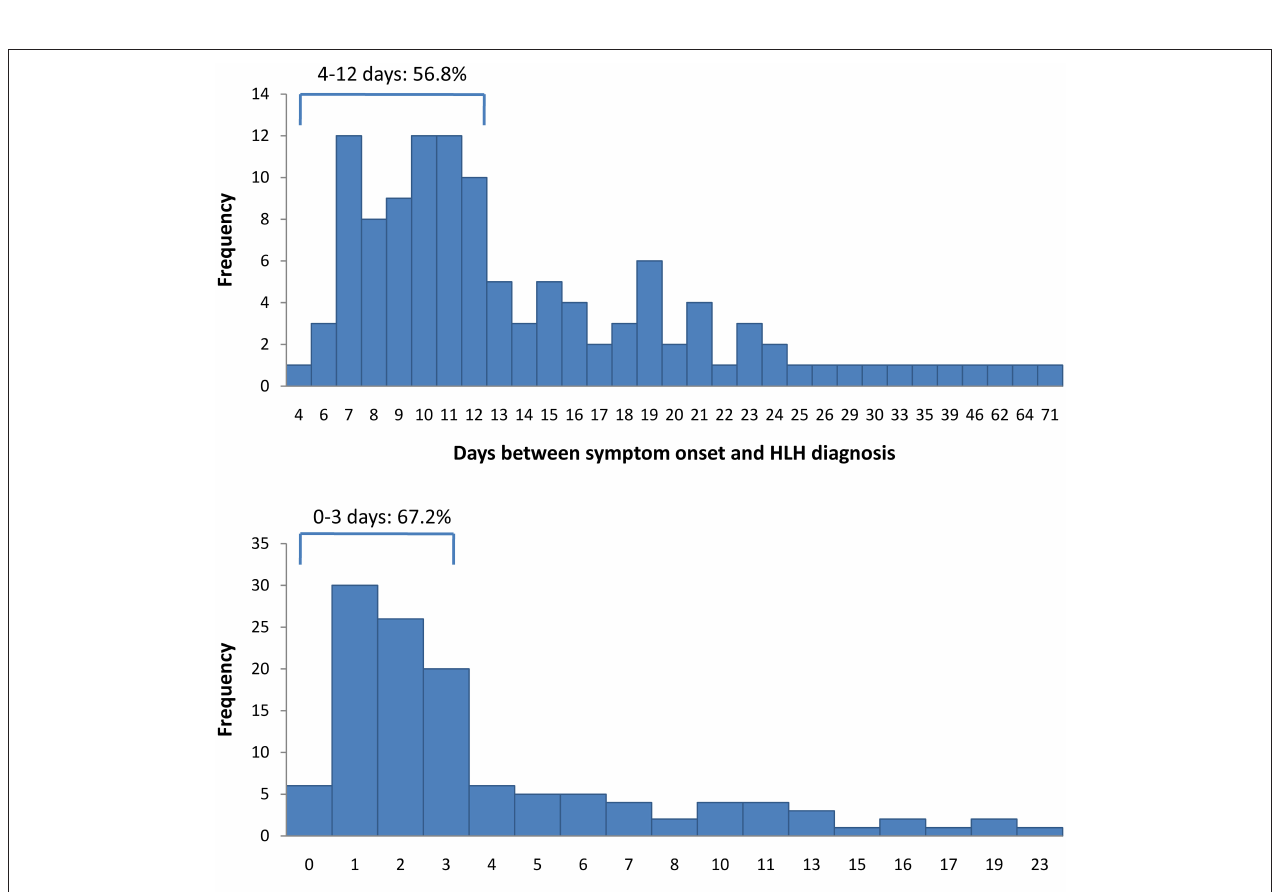
FIGURE 2 | Distribution of diagnostic time-lags among 122 patients with haemophagocytic lymphohistiocytosis. Top: first symptom onset to diagnosis time lag. Bottom: hospital admission to diagnosis time lag. HLH, haemophagocytic lymphohistiocytosis.